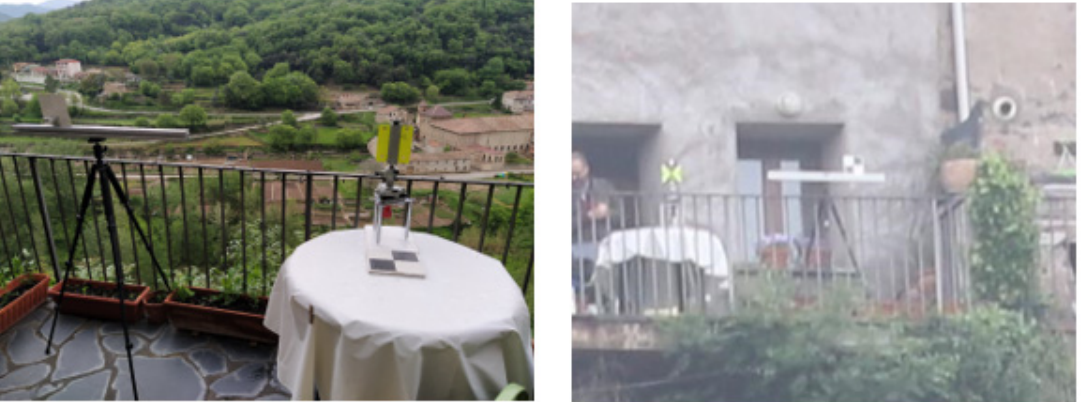
Figure 3. Image of the targets and the device used to control the movements from their own place ( left ) and from the cameras ( right ). Table 1. Discrepancies between the real displacement and the displacement measured in the